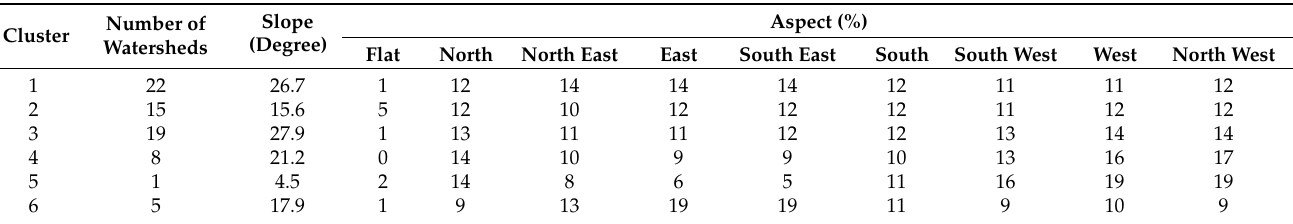
Figure 2. Result of cluster analysis on watersheds. ( a ) Cluster distributions, ( b – g ) represent the NDVI (in green line), temperature (in red line), and rainfall (in the blue bar) for clusters #1 to #6. Table 1. Number of watersheds, average slope, and percentage of aspect for each